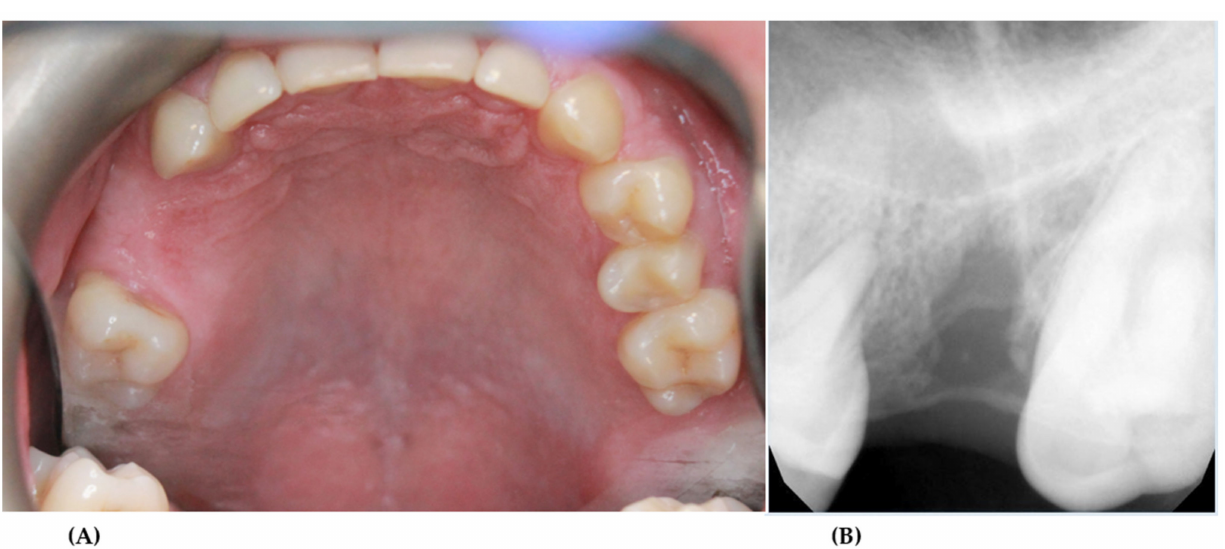
Figure 5. Intraoral photographs after 10th mouths after surgical treatment ( A ); dental X-ray—10th months after 27 extraction—stabilization of bone healing ( B